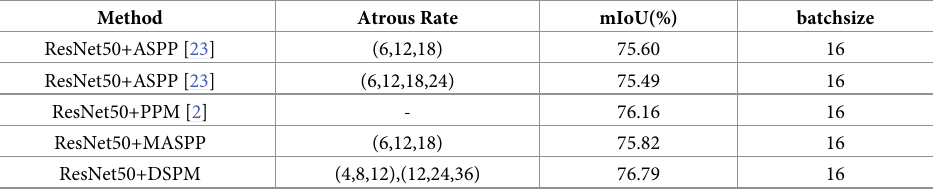
Table 2. Ablation results on the PASCAL VOC 2012 valuation set. ASPP is Atrous spatial pyramid pooling. MASPP refers to replacing the 1 × 1 convolution layer of ASPP with a 3 × 3 depthwise separable convolution layer. DSPM is our Double Attention Pyramid